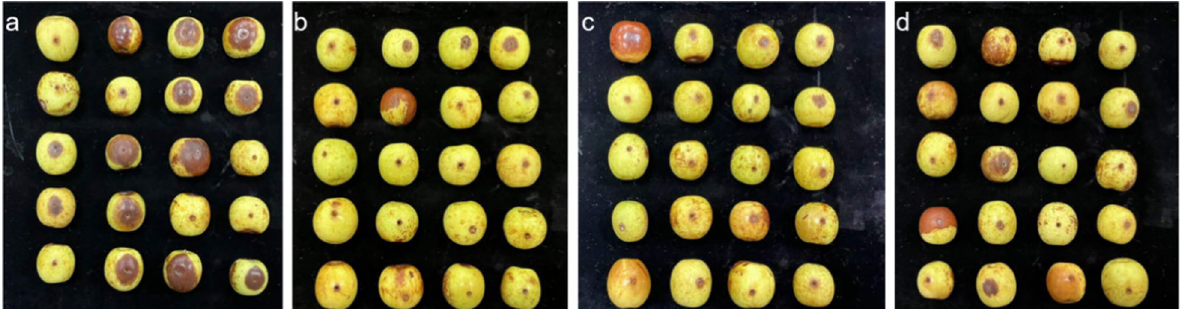
Fig. 3 Disease characteristics of winter jujube inoculated by gray mold treated with surfactin at different concentrations for 3 days a : control group without surfactin treatment; b EC 50 surfactin treatment group; c : 4 EC 50 surfactin treatment groups; d : 8 EC 50 surfactin treatment